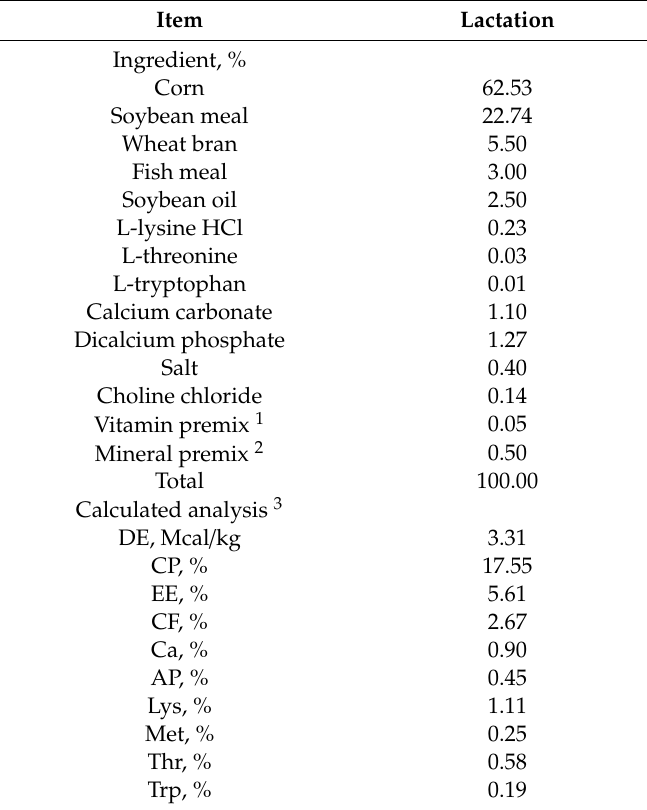
Table 2. Composition and calculated analysis of lactation diet (as-fed